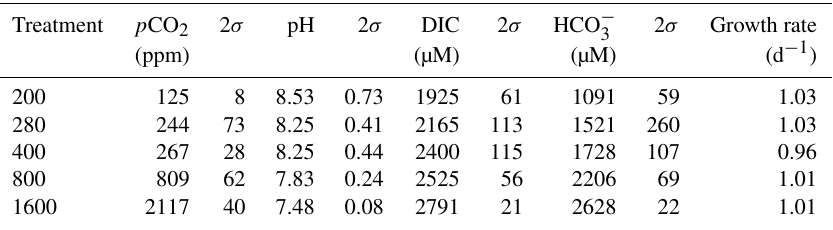
Figure 1. Diatom growth rate and cell size as a function of pH labelled according to CO 2 treatment. Linear-least-squares regressions, including R 2 and p values are also shown. Table 1. Mean carbonate system parameters experienced under the average growth conditions as calculated for each culture treatment on the basis of the number of cells grown in each 24h period of the batch